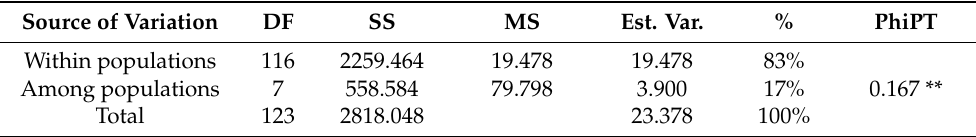
Table 4. The analysis of molecular variance (AMOVA) of Astragalus exscapus subsp. transsilvanicus populations using SRAP markers. Source of Variation